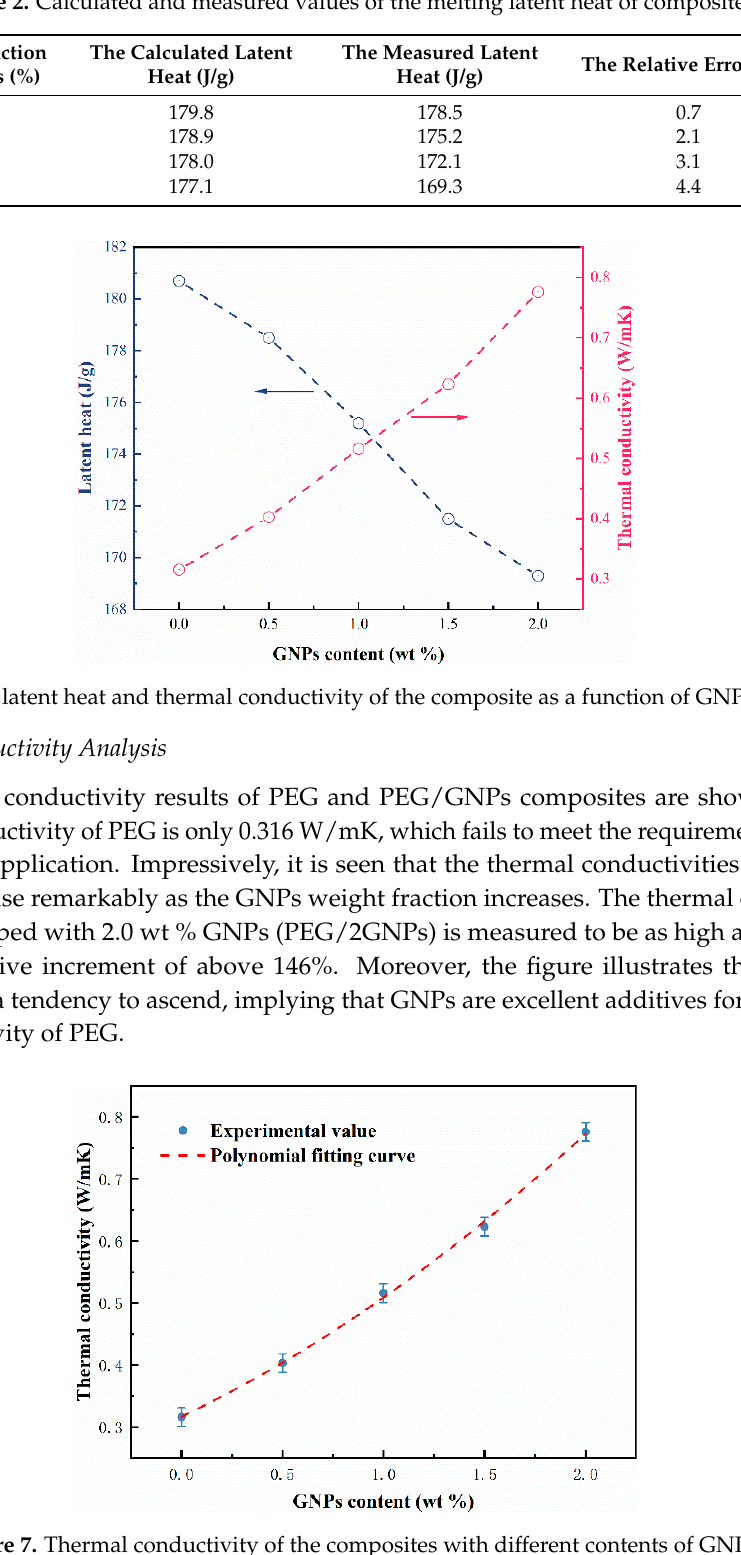
Table 1. DSC melting and solidifying characteristics of pristine PEG and PEG/GNPs ‐ X% composites.